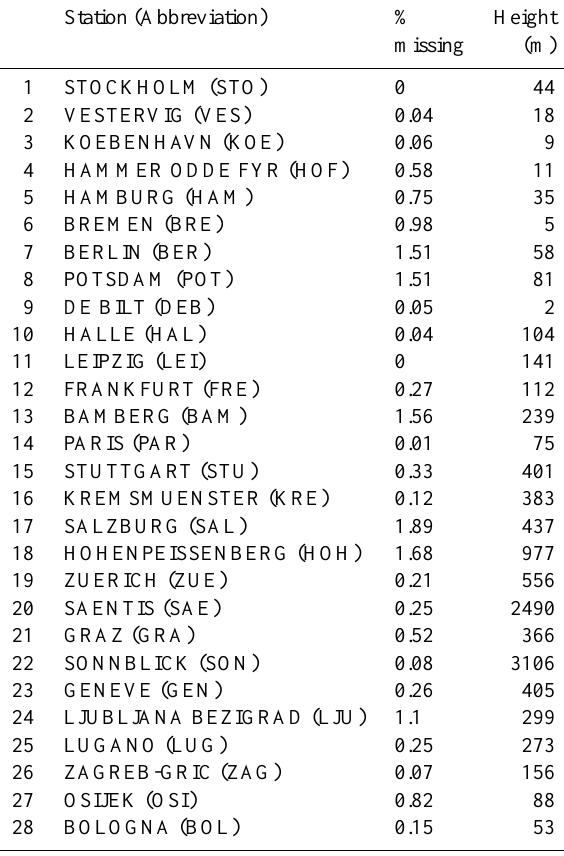
Table 1. Daily mean air temperature data